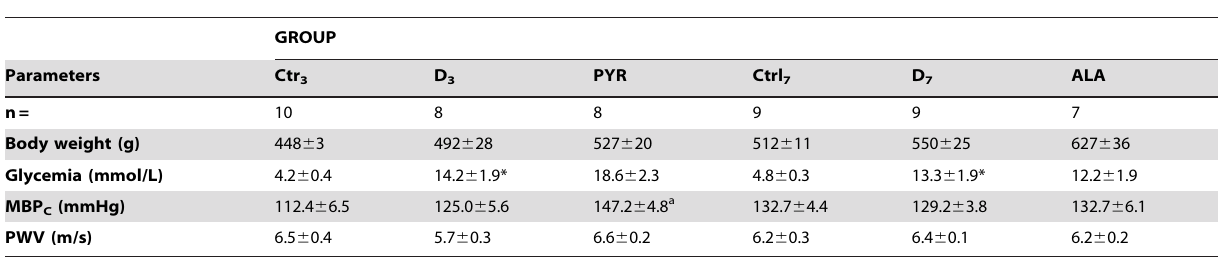
Table 1. Anti-AGEs treatments: metabolic and hemodynamic